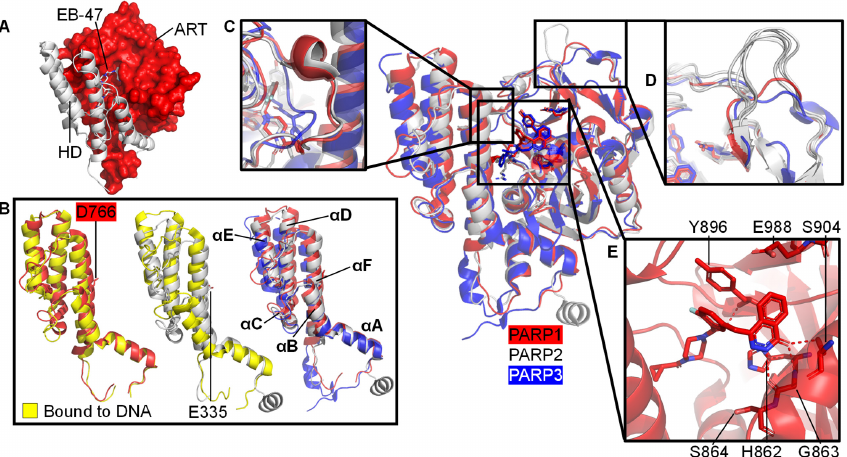
Figure 3. Structural details of the CAT domains of PARP1-3. Central image shows a structural superposition of the ART domains of PARP1 (red, olaparib-bound, PDB 7AAD [109]), PARP2 (white, olaparib-bound, PDB 4TVJ [115]), and PARP3 (blue, ME0354-bound, PDB 4GV2 [116]) with highlighted features. ( A ) A folded HD (white) occludes the NAD + binding pocket in the PARP1 ART domain (red, PDB 7AAB, PARP1 with NAD + analogue EB-47 bound [109]); ( B ) Subtle movement of parts of the HD domains in response to DNA binding after superposition of the ART domain only. Left: HD of apo PARP1 before (red, PDB 7AAA [109]) and after (yellow, PDB 4DQY [34]) DSB model binding. Middle: HD of PARP2 before (white, PDB 4TVJ [115]) and after (yellow, PDB 6X0N [53]) DSB model binding. Right: HDs of PARP1, PARP2, and PARP3 in complex with inhibitors as specified above with annotation of the helices; no DNA binding; ( C ) Close-up of the D-loop of PARP1 and PARP2, which is absent in PARP3; ( D ) The acceptor loop of five representative PARP2 structures (white: PDBs 4ZZX [117], 6X0L, 6X0M, 6X0N [53], 4TVJ [115]) contains a unique insertion compared to PARP1 (red, PDB 7AAD, bound to olaparib [109]) or PARP3 (blue, PDB 4GV2, bound to ME0354 [116]). This is suggested to increase branching of PAR chains by PARP2 [112]; ( E ) Close-up of the NAD + binding pocket of PARP1 (red, olaparib-bound, PDB 7AAD [109]). The catalytic triad involving H862, Y896, and E988 and the residues interacting with PARPi, G863-S864, and S904, are indicated.